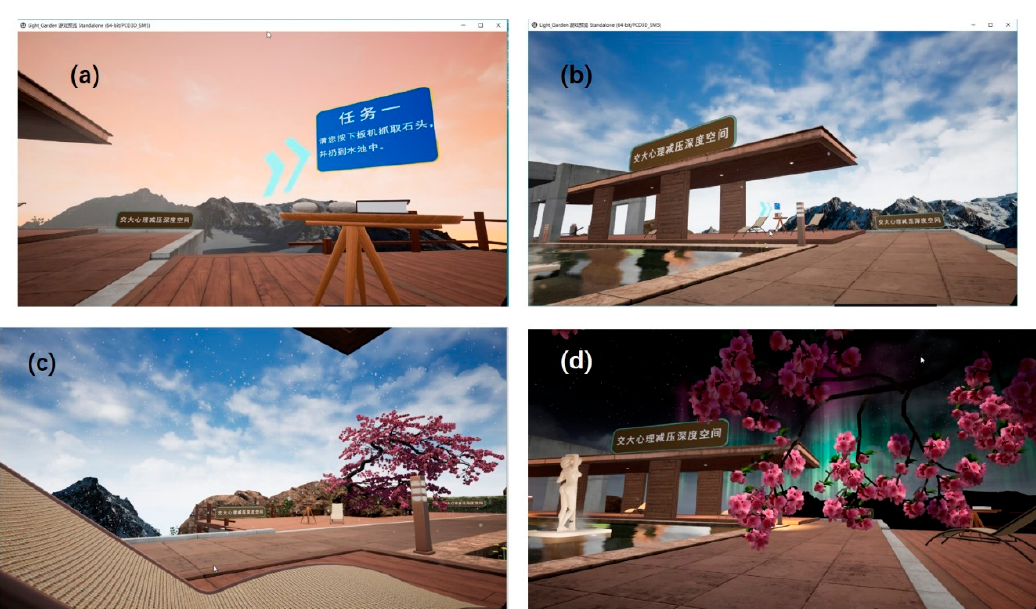
Figure A2. Screenshots from ST-ART showing ( a ) the task 1, ( b ) the reward following task 1 (clear sky), ( c ) the light snow during task 2, and ( d ) the reward following task 3